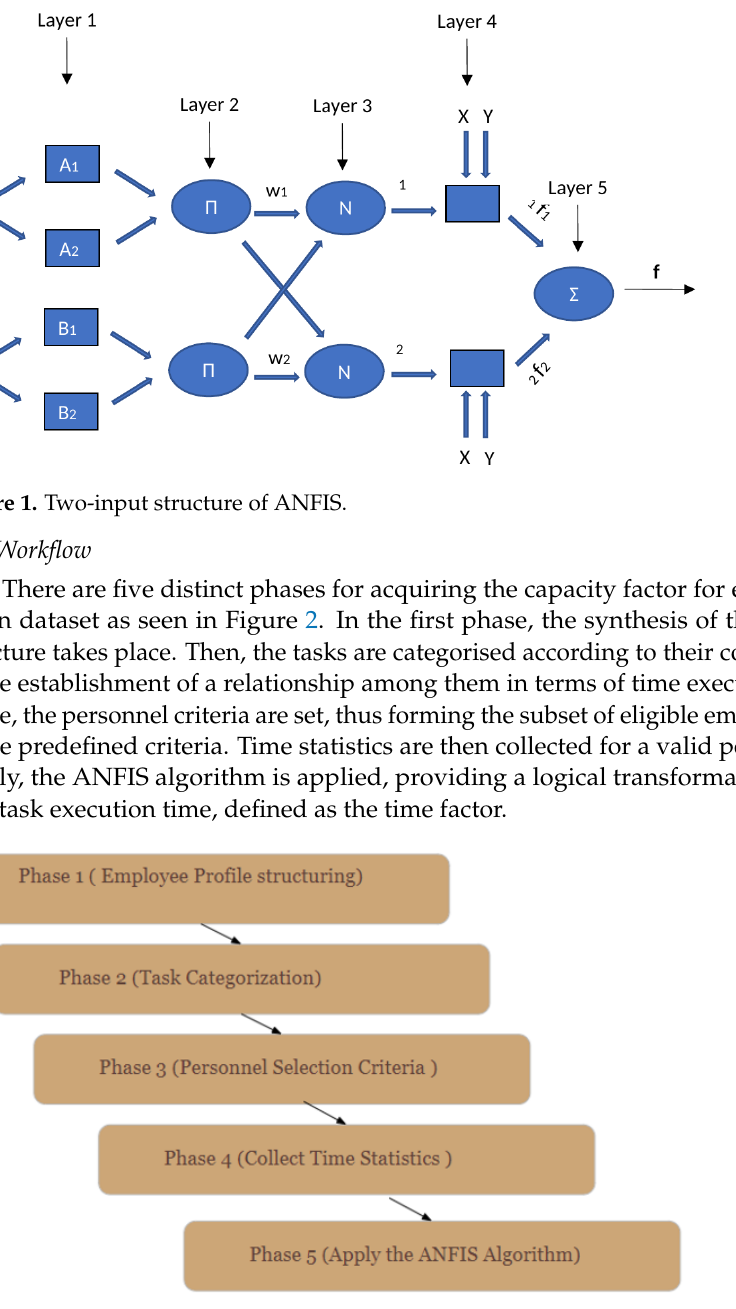
Figure 2. Workflow phase of the